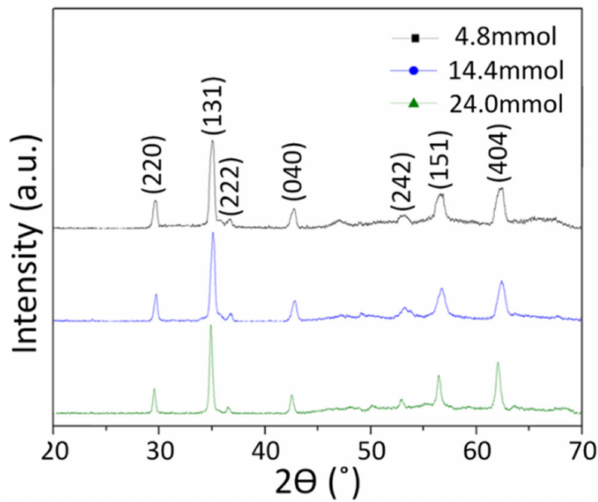
Figure 8. X-ray di ff raction patterns of the calcined Ni 0.5 Zn 0.5 Fe 2 O 4 nanofibers obtained from precursor solutions 15-A, 15-B, and